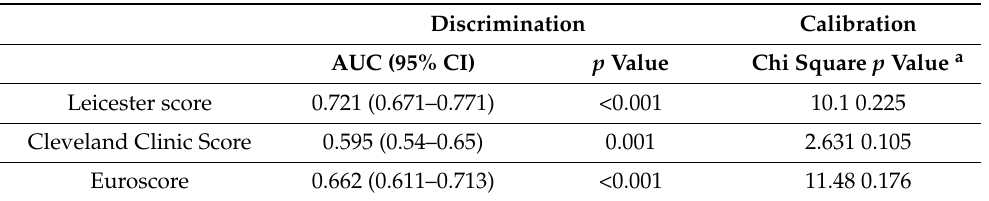
Table 6. Discrimination (area under ROC curves) for the different scores and calibrations (Hosmer– Lemshow tests).